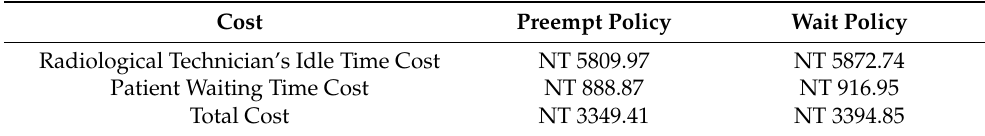
Table 12. Cost analysis of the preempt policy and the wait